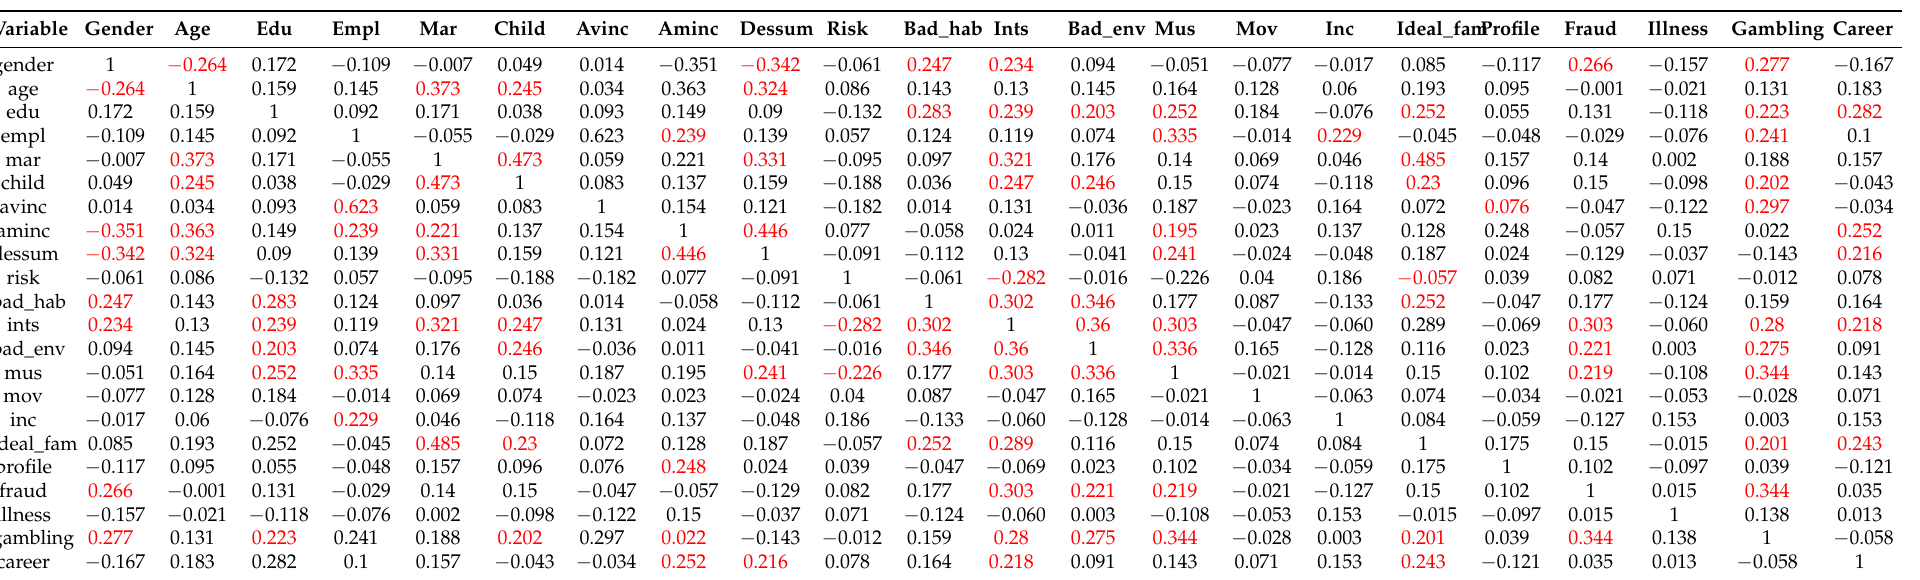
Table 3. Spearman rank order correlations (correlations significant at p < 0.05 are marked in